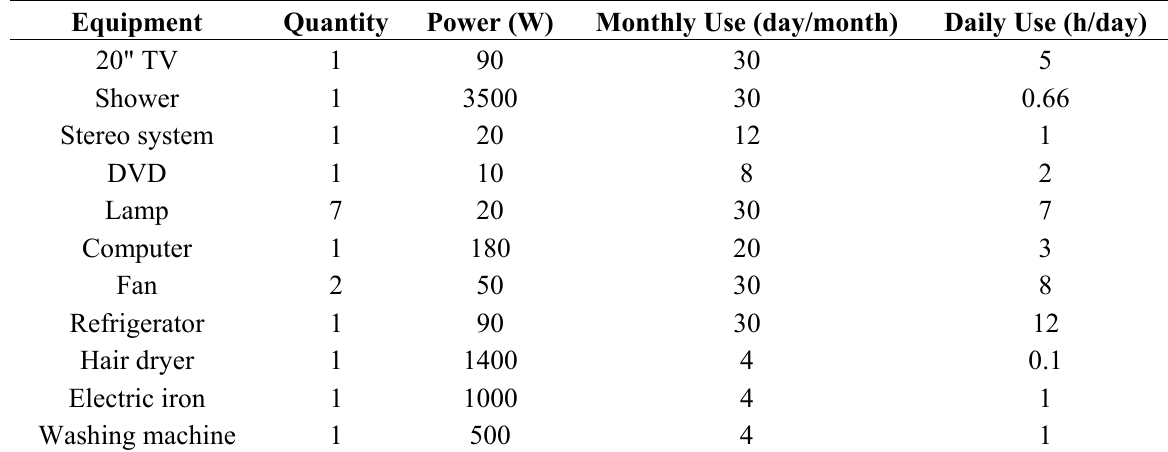
Table 2. Loads for sizing photovoltaic system for a typical residence.